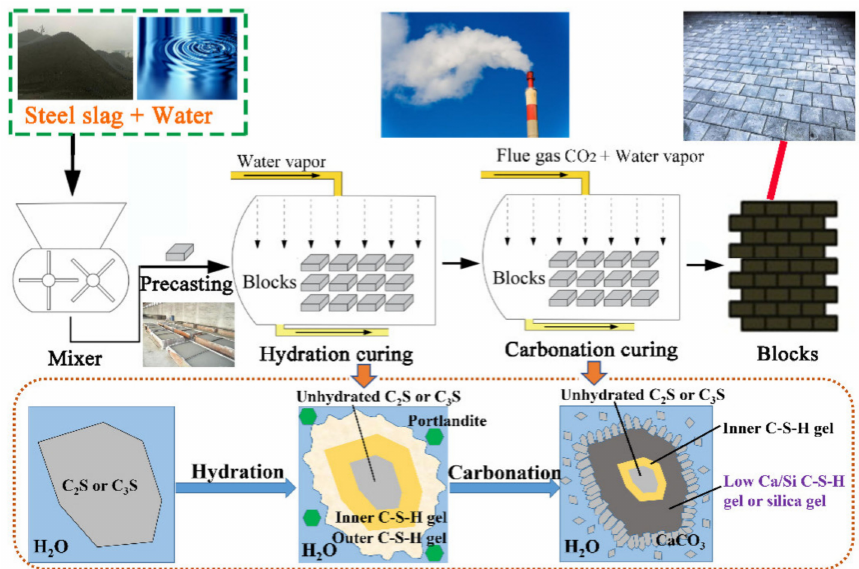
Figure 2. Hydration and carbonation curing of steel slag for building materials and their reaction mechanisms (reprinted with permission from Wang et al. [32], Copyright 2021